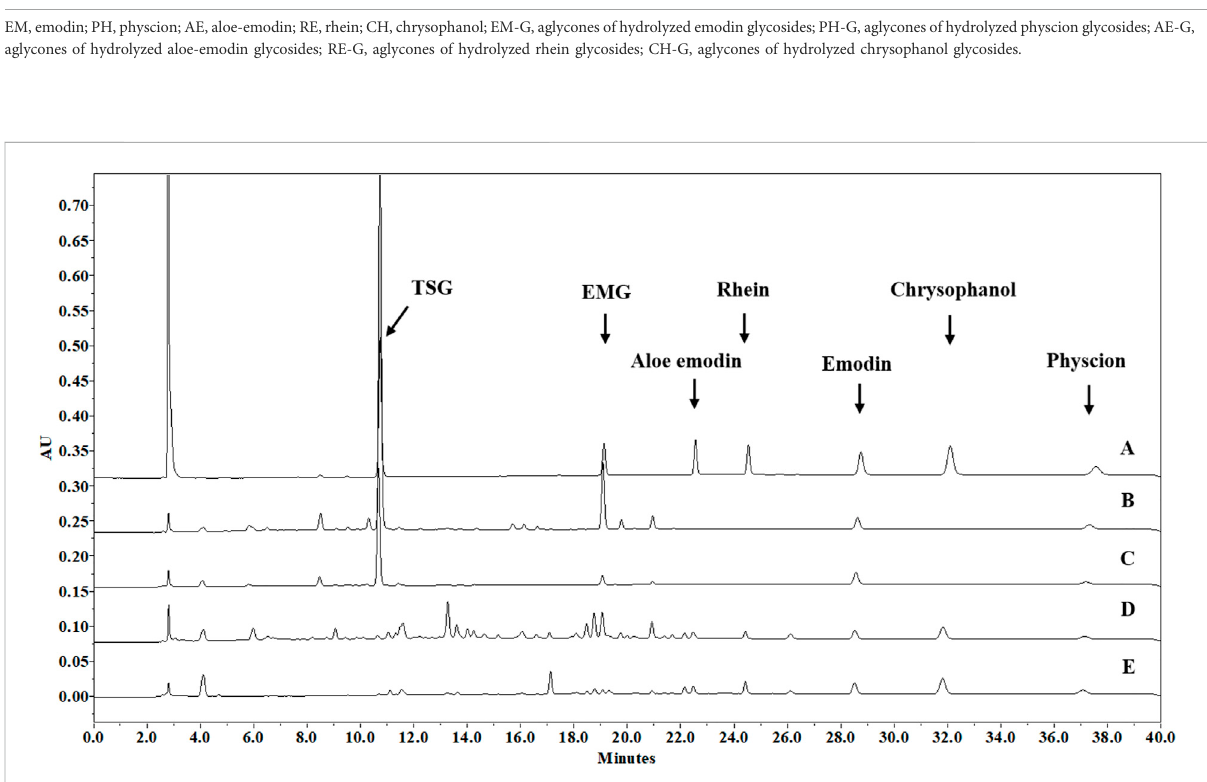
FIGURE 2 HPLC-UVchromatograms(275 nm)ofsevenmajorcharacteristiccomponentsinPM,rhubarbandtheirconcoctedherbalextracts. (A) Standard methanolsolution,containingTSG(100 μ g/ml),EMG(10 μ g/ml),aloe-emodin(10 μ g/ml),rhein(15 μ g/ml),emodin(10 μ g/ml),chrysophanol(10 μ g/ ml) and physcion (5 μ g/ml). (B) PME methanol solution of 1.4 mg/ml (dry weight/methanol, w/v), containing TSG (228 μ g/ml), EMG (17.3 μ g/ml), emodin (4.86 μ g/ml), and physcion (1.92 μ g/ml); (C) PMPE methanol solution of 1.1 mg/ml (dry weight/methanol, w/v), containing TSG (57.6 μ g/ml), EMG (2.91 μ g/ml), emodin (4.80 μ g/ml), and physcion (1.28 μ g/ml); (D) RME methanol solution of 1.3 mg/ml (dry weight/methanol, w/ v), containing EMG (6.24 μ g/ml), emodin (3.61 μ g/ml), physcion (1.30 μ g/ml), aloe-emodin (1.34 μ g/ml), rhein (2.83 μ g/ml), and chrysophanol (6.82 μ g/ml); (E) RMPE methanol solution of 0.8 mg/ml (dry weight/methanol, w/v), containing EMG (1.08 μ g/ml), emodin (4.84 μ g/ml),